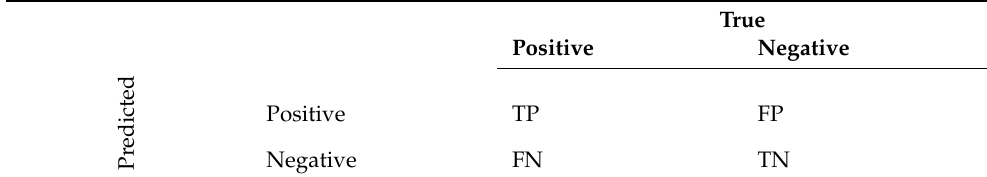
Table 2. Confusion